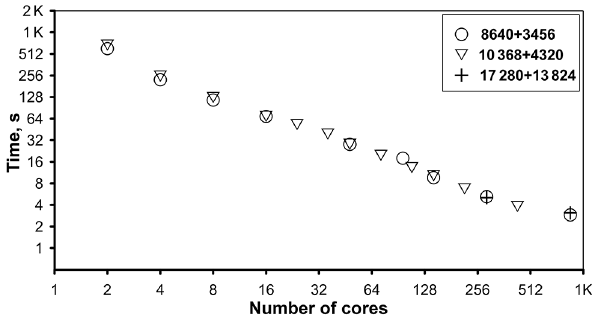
Figure 4. Wall-clock time required for the 10-day ocean– atmosphere model run with disabled physics vs. number of coupler cores on BlueGene/Q supercomputer, for different decomposition sizes of the ocean and atmosphere models (Test II for